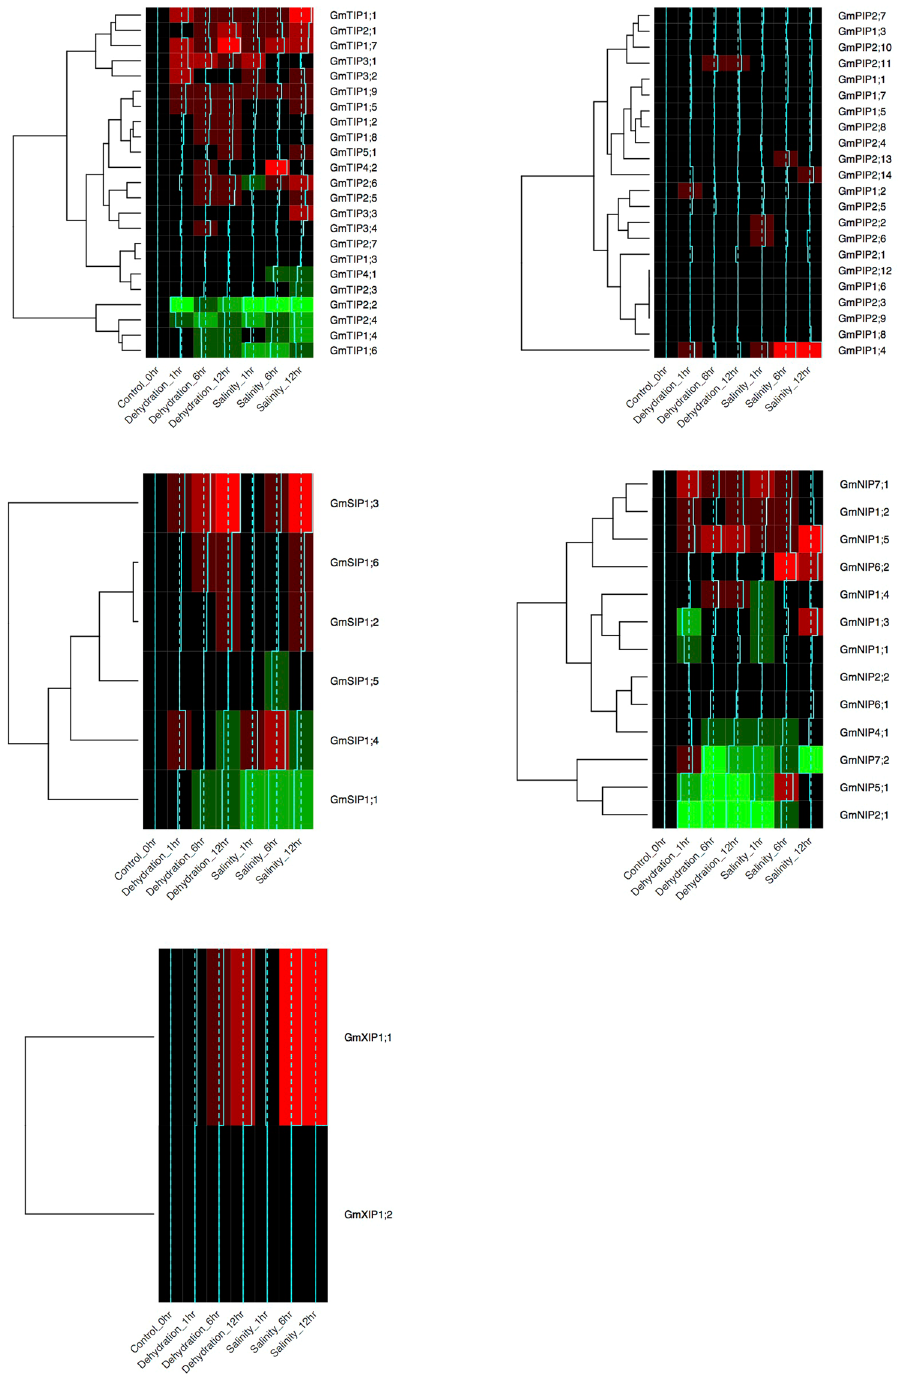
Figure 3. Expression profiles of GmAQPs under salt and dehydration. Expression of different GmAQPs after salinity and dehydration stress at different time points plotted as heatmaps. The expression data (Reads Per Kilobase Million) values were plotted after normalization for each gene with respect to control. The color pattern shows the range of expression from lowest expression level (green) to highest expression level (red), black is the median expression